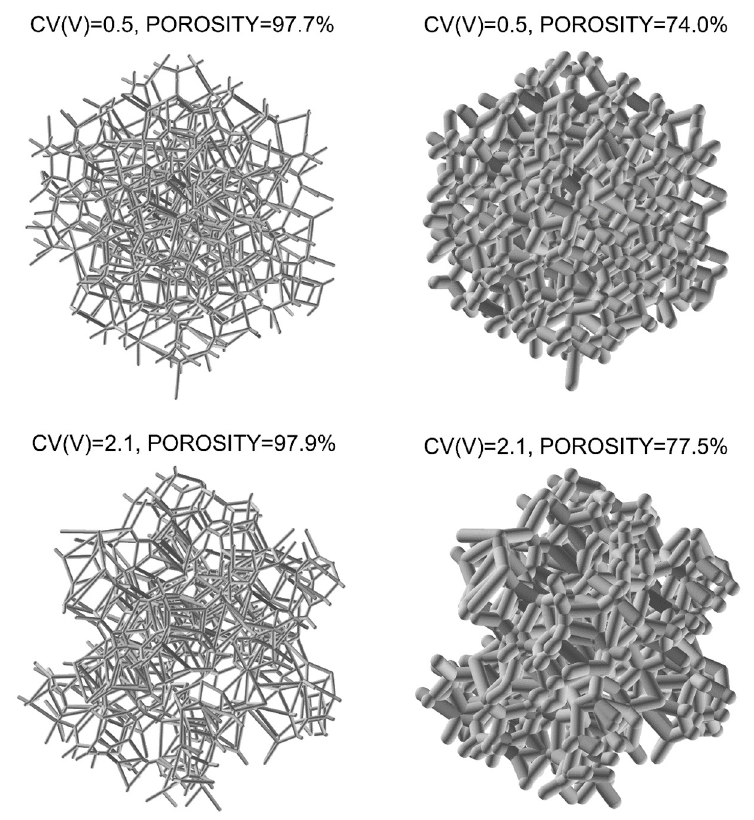
Figure 2. Examples of designed LVT open-cell foams with various CV(V).